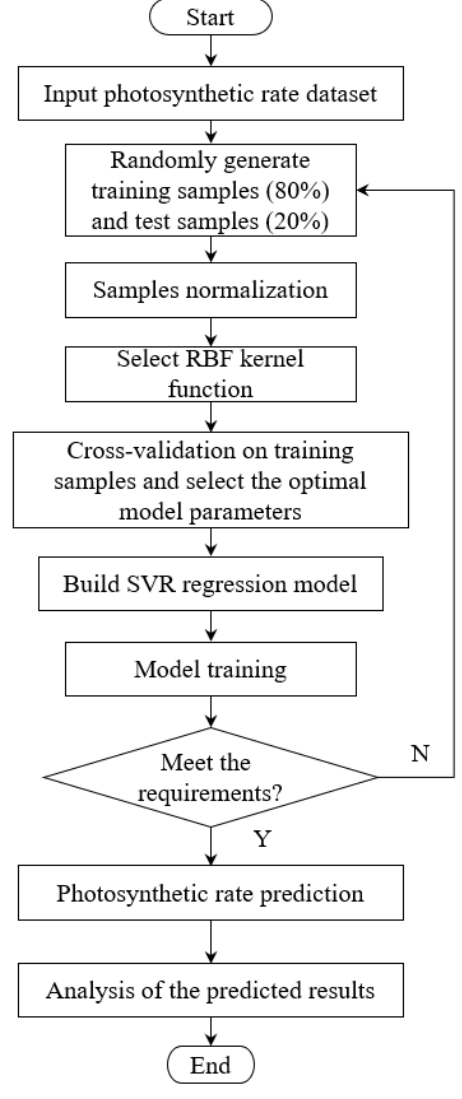
Figure 2. Flow chart of the photosynthetic rate prediction model.